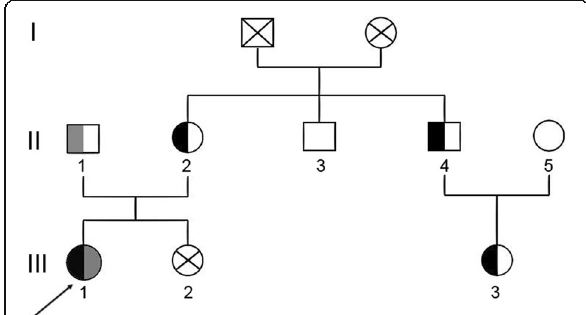
Fig. 4 Pedigree chart of the proband ’ s family. The arrow indicates the proband. Filled symbols indicate subjects affected by gene mutations (c.1919A > G is marked as black and c.2522A> G is marked as grey). Men are indicated by squares, and women are indicated by circles. III1, the proband, III2, sister, III3, cousin, II1, father,